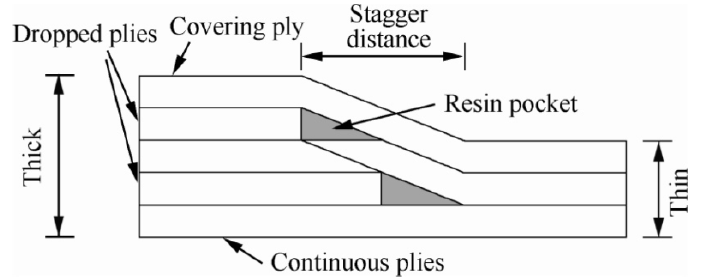
Figure 2. Tapered composite